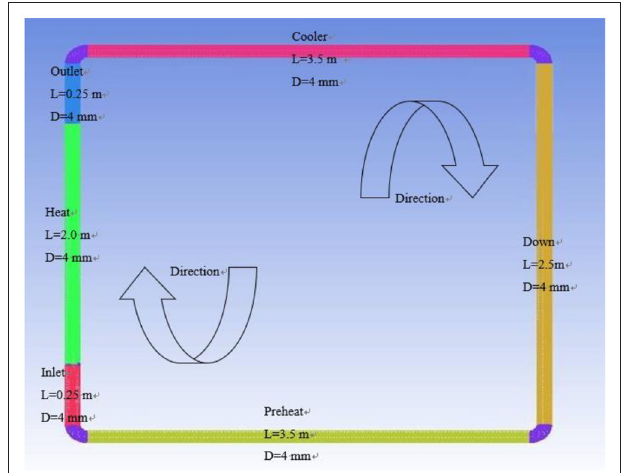
FIGURE 1 | Natural circulation loop.